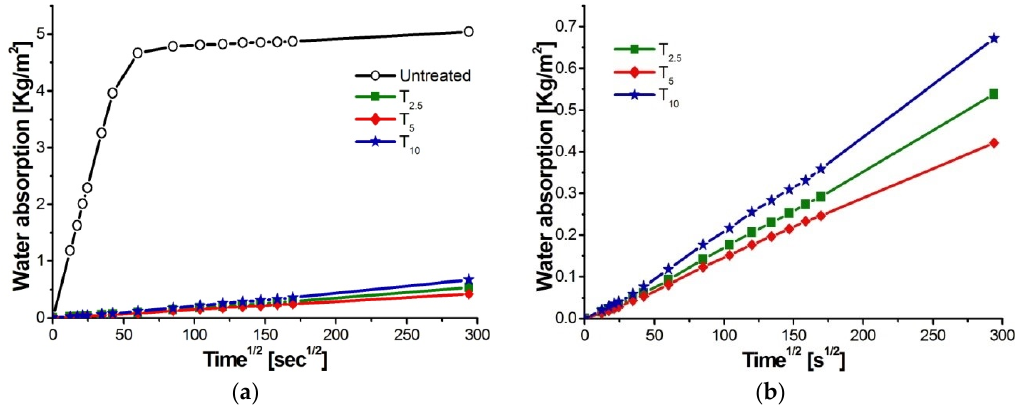
Figure 7. Capillary water absorption curves: in ( a ) untreated and treated samples are compared; in ( b ) only the curves related to the treated samples are reported. Table 4. Water absorption by capillarity: water absorbed at the end of the test ( Q 24 h ) and the capillary absorption coefficient (AC). For each data set the standard deviation is reported.